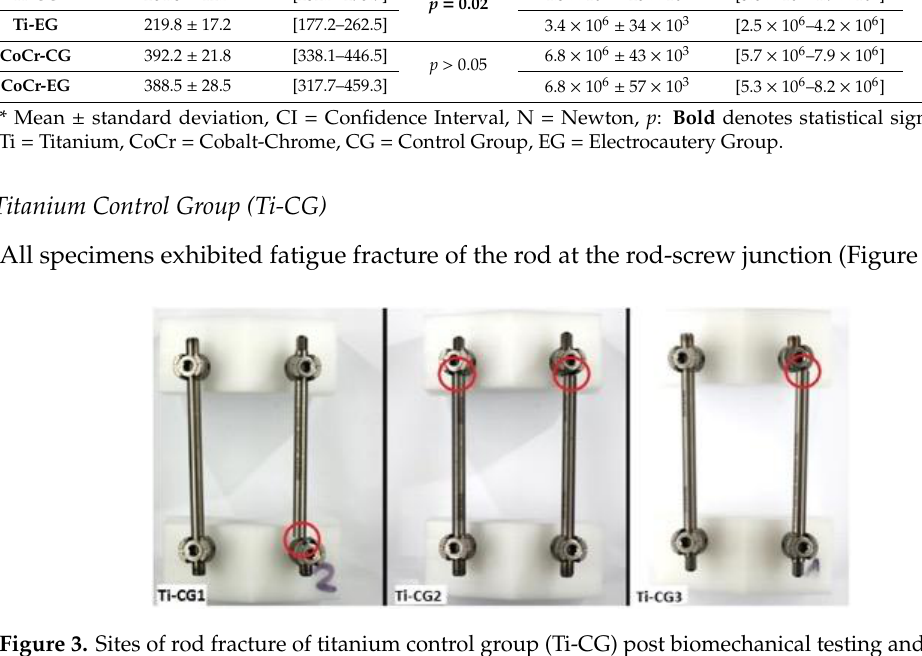
Figure 4. Sites of rod fracture of titanium electrocautery group (Ti-EG) post biomechanical testing.